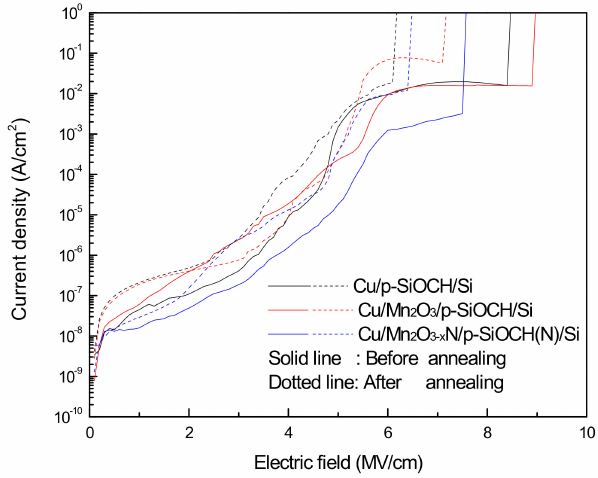
Figure 3. J-E plots of various Cu-gate MIS capacitors before and after annealing at 450 ◦ C for 2 h.